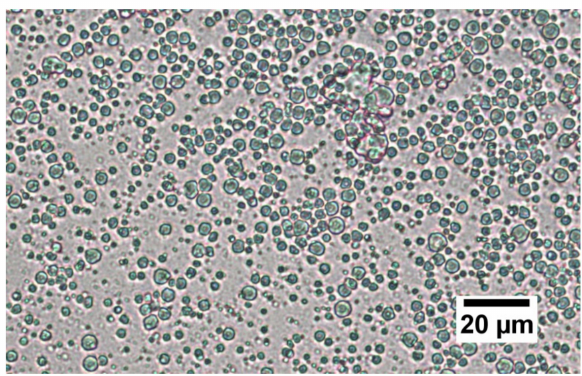
Figure 7. A typical microscopy picture of the natural organic hay milk used for the milk emulsions in this paper. The magnification is 40 ×